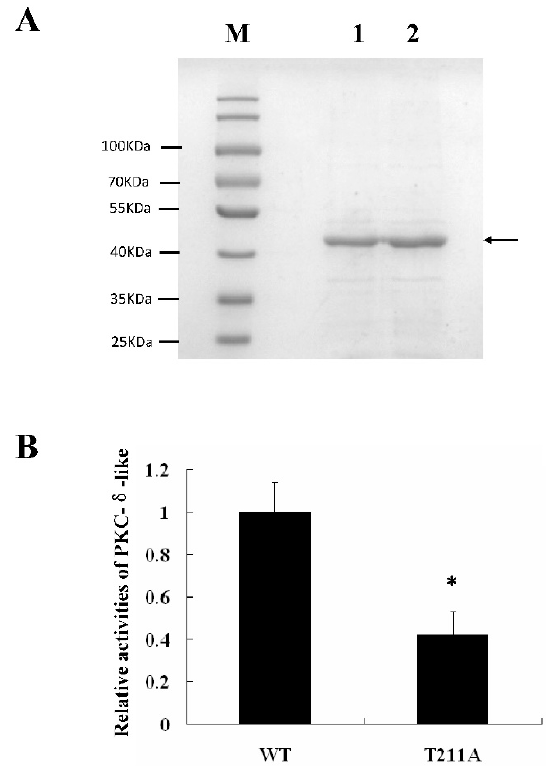
Figure 5. Activity assay of PKC- δ -like-CF and PKC- δ -like-CF (T211A) in vitro. ( A ) Expression and purification of PKC- δ -like-CF and PKC- δ -like-CF (T211A) recombinant protein. The recombinant proteins were expressed in E. coli BL21 and analyzed through SDS-PAGE. M, protein marker; lane 1, purified PKC- δ -like-CF recombinant protein; lane 2, purified PKC- δ -like-CF (T211A) recombinant protein. ( B ) Activity assay of PKC- δ -like-CF and PKC- δ -like-CF (T211A). The asterisk indicates p < 0.05.